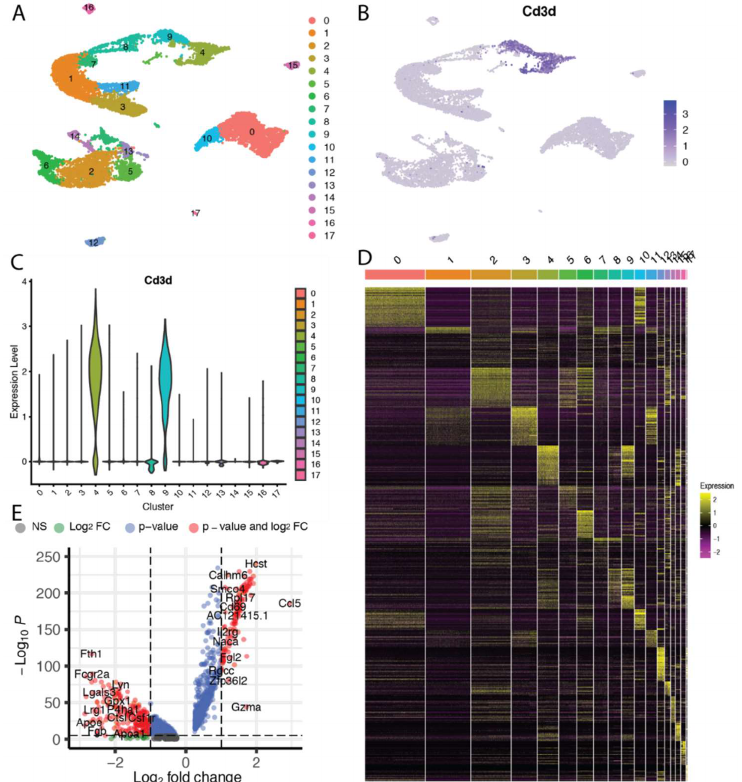
Figure 2. Common visualization approaches for scRNAseq data. In this example, intratumoral CD45+ immune cells isolated from orthotopic liver tumors in a rat model of hepatocellular carcinoma were sequenced using the 10X Genomics platform. Visualizations were created using the Seurat [204] and EnhancedVolcano [205] packages in R (R Foundation). ( A ) A common ‘first’ step in analyzing scRNAseq data is to discretize the cells in either a supervised or unsupervised manner into clusters of cells with similar expression patterns. These clusters can then be visualized in a t-distributed stochastic neighbor embedding (t-SNE) map where the relative similarity in expression patterns between cells is depicted in their relative proximity on a 2- or 3-dimensional diagram. ( B ) Feature maps allow for the visualization of specific genes or gene sets across the t-SNE map. In this case, the expression of the Cd3d gene was closely correlated with clusters 4 and 9, indicating that these clusters are comprised of T lymphocytes. ( C ) Another method to readily visualize the expression of genes or gene sets across clusters is with violin plots. ( D ) Heat maps are a common method to visualize differentially expressed genes across a group of samples or cell clusters. ( E ) The statistical significance as well as the magnitude of differentially expressed genes can be visualized simultaneously on volcano plots.